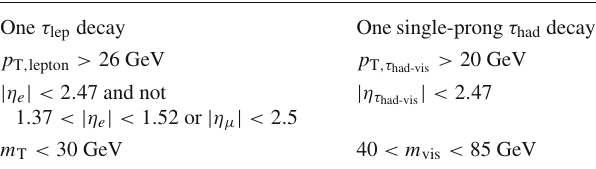
Table 2 Definition of fiducial region for Z /γ ∗ → ττ decays. The requirements are applied at stable-particle level. Here, the E miss calculated from the momenta of the neutrinos that originate from the Z /γ ∗ → ττ decays One τ lep